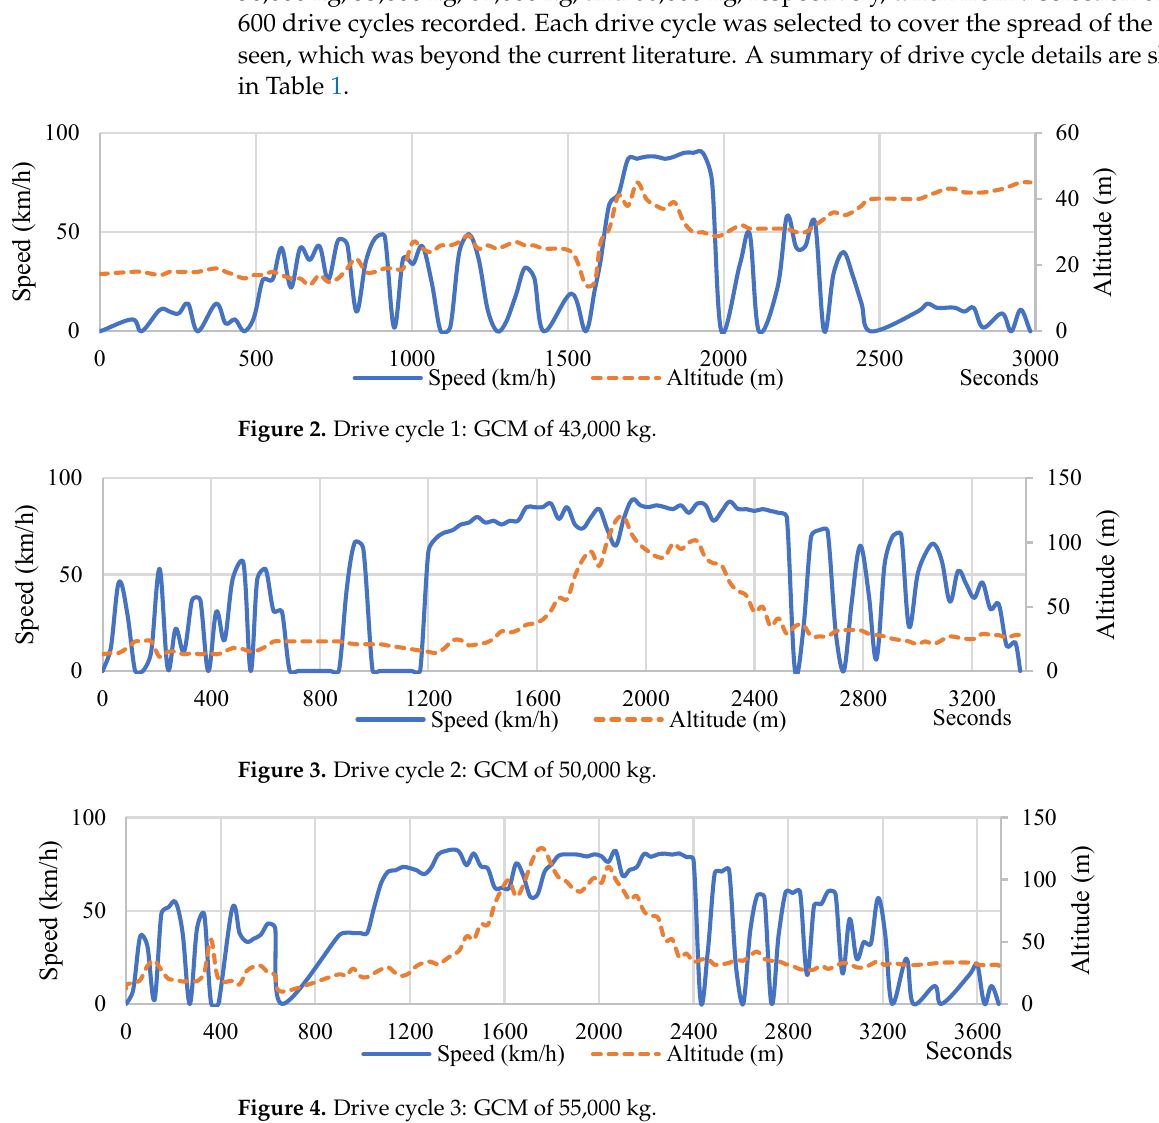
Figure 5. Drive cycle 4: GCM of 61,000 kg. Figure 6. Drive cycle 5: GCM of 66,000 kg. Table 1. Drive cycle summary. Drive Cycle